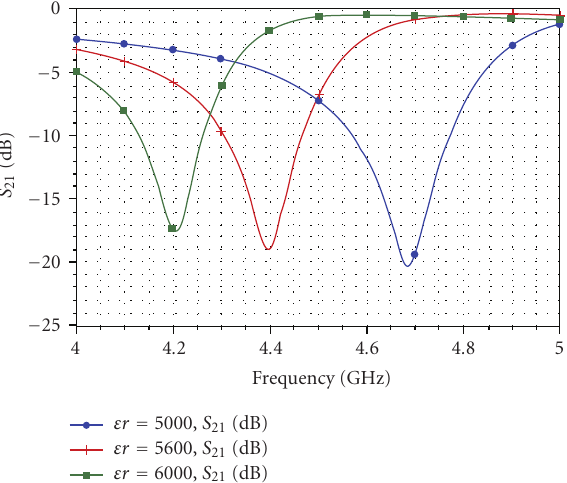
Figure 8: Frequency response ( S 21 (dB))—of tunable multilayer structure.